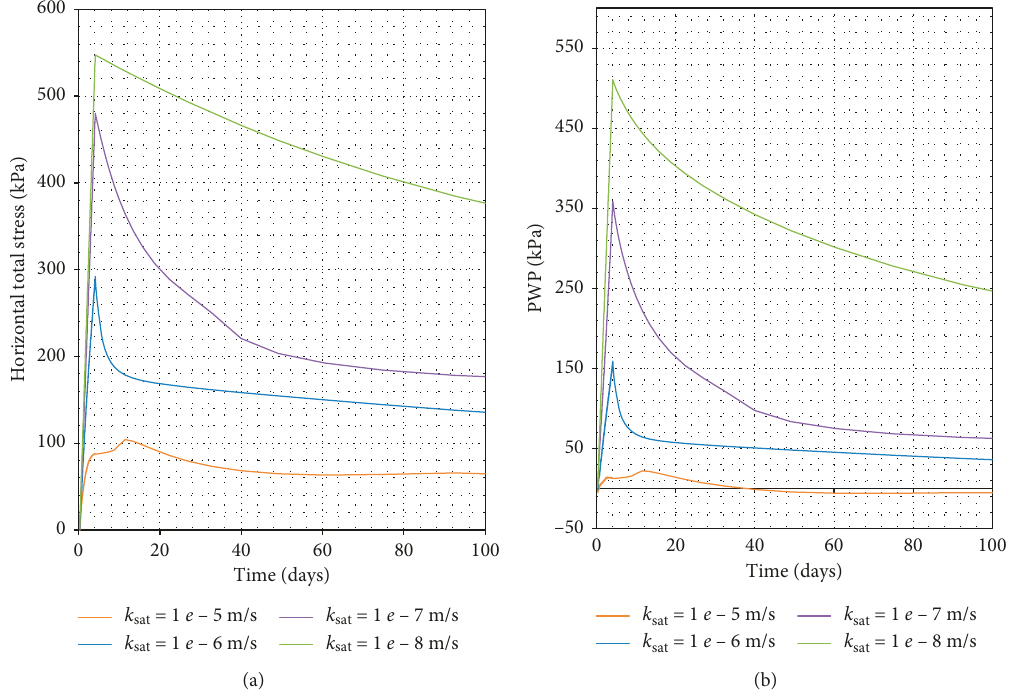
Figure 10: Evolution of the (a) horizontal total stress σ h and (b) PWP u w at midheight of the barricade for four different hydraulic conductivities of backfill (see the details in Table 1, Case 2). after the start of stope filling for filling rate V of 0.1, 0.2, 0.3, 0.4, and 1 m/h. When the stope filling rate is 1 m/h, the horizontal total stress and PWP reach a peak value shortly (Figure 13(b)) at midheight of the drift on the barricade,